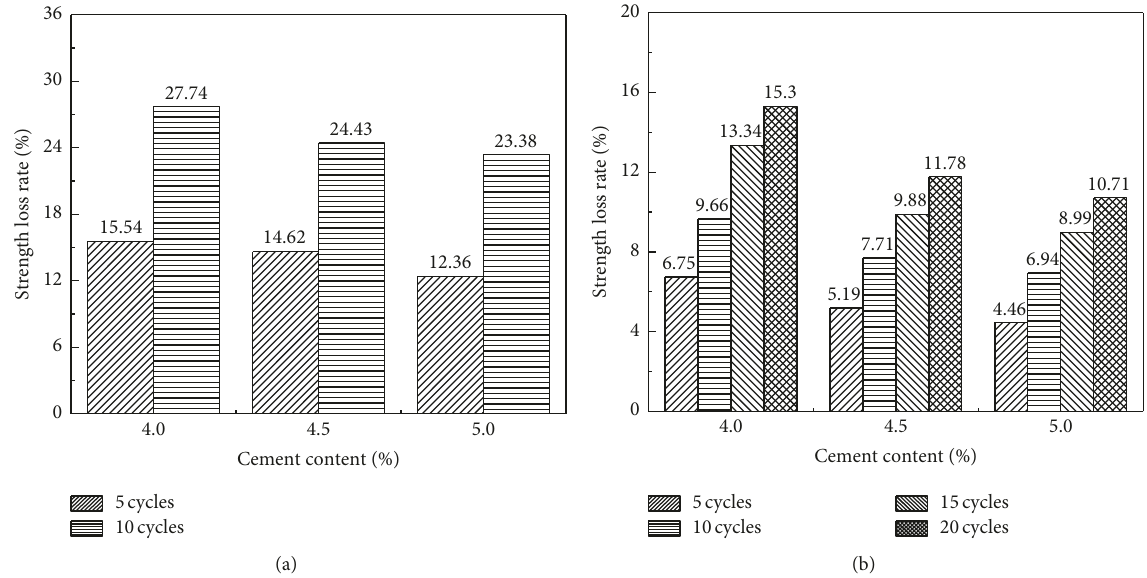
Figure 18: Strength loss rates of the SRBMs after different numbers of freeze-thaw cycles: (a) curing time = 28 d; (b) curing time = 90 d.